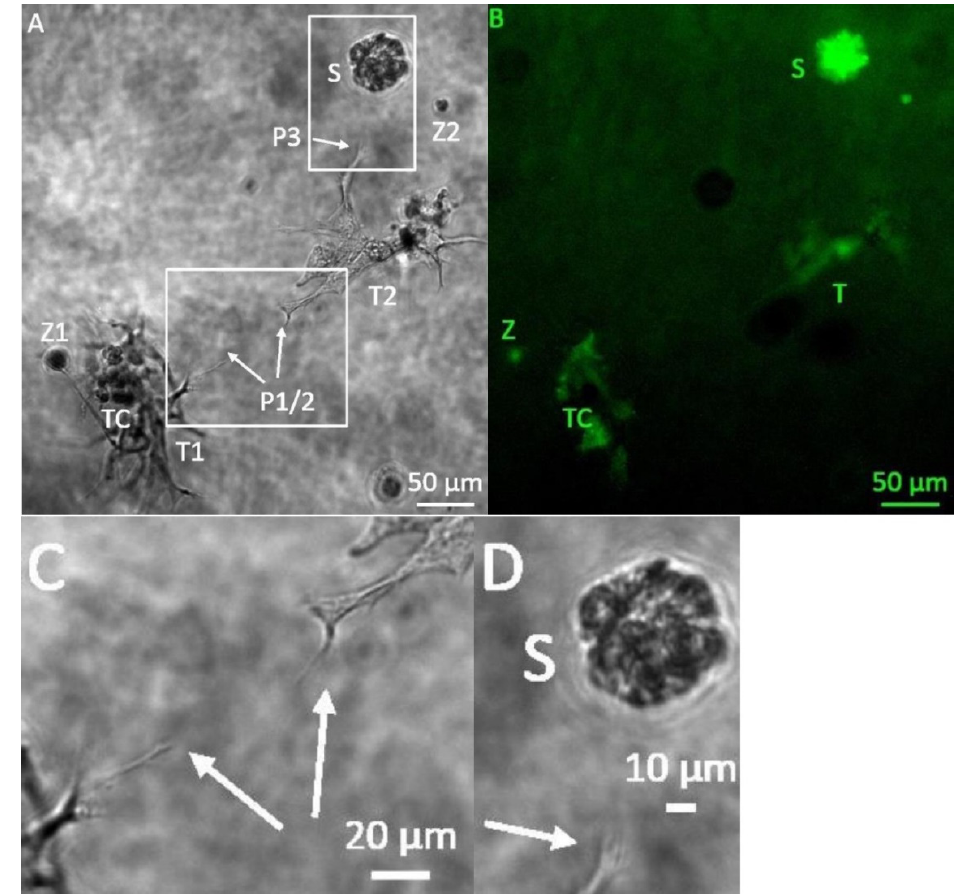
Figure 1. Representative microphotographs of 3D hydrogel tumor-stroma cultures on day 6. ( A ): Tubule-like structures showed increased bifurcation after a cultivation period of 6 days. From the tubular structure T2 in the middle, one structure moves upwards (arrow P3) towards the H838 tumor spheroid (S). One bifurcation of each tubular structure T moves towards each other (arrows P1/2). The left structure (T1) also shows strong cell attachments (TC). In addition, a spherical cell accumulation (Z1) and a small roundish cell accumulation (Z2) is visible. ( B ): GFP fluorescent micrograph of A. The spheroid (S) is strongly GFP-positive, as are the cell attachments (TC) and the spherical cell accumulations (Z1/2). ( C ): Enlarged section at P1/2. ( D ): Magnified section at